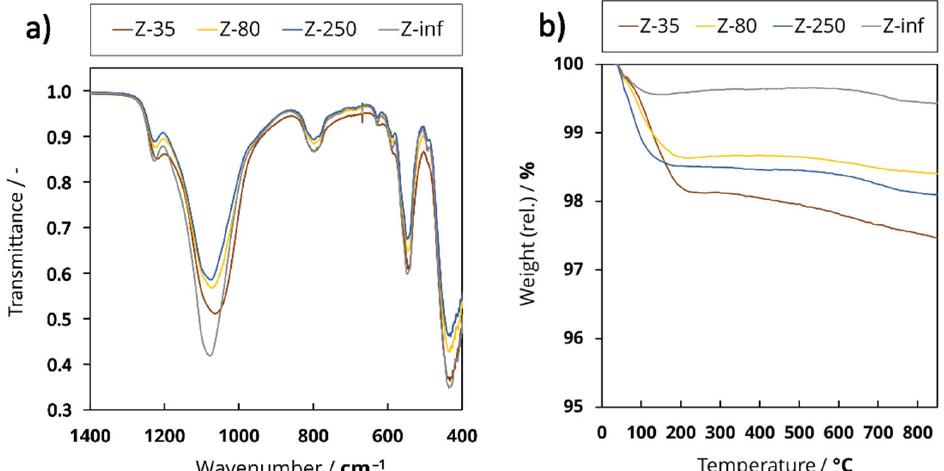
Figure A2. Additional material characterization: ( a ) ATR-FT-IR transmission spectra of the prepared H ZSM-5 zeolite samples; special focus on transmission at 450 cm − 1 and 550 cm − 1 to determine crystallinity by Shukla and Pandya [43]; ( b ) thermogravimetric analysis between 35 ◦ C and 850 ◦ C in nitrogen flow of H-ZSM-5, slightly higher hydrophilicity for Al-rich material at similar thermal stability.